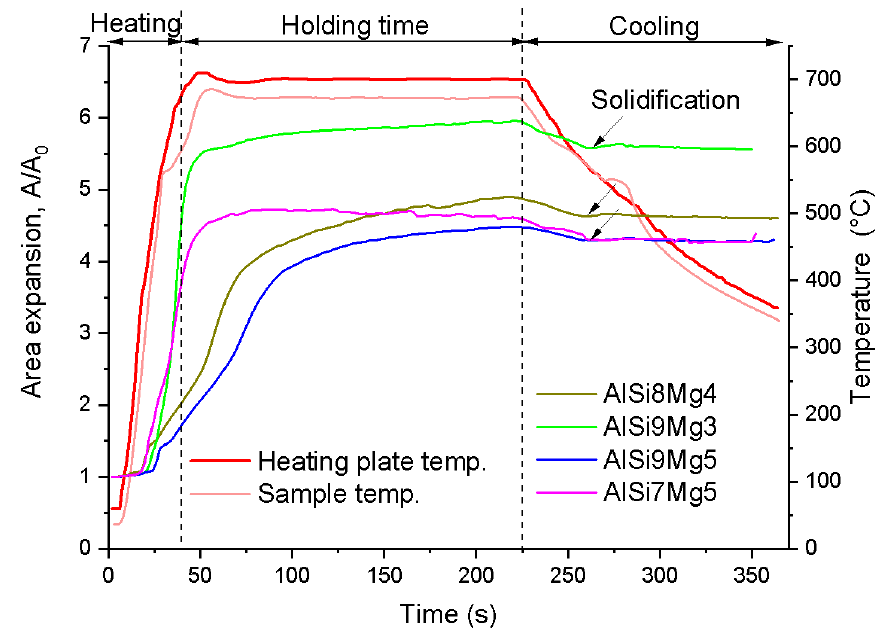
Figure 3. Area expansion curves for selected samples of different alloy composition and the common temperature profiles of the heating plate and the sample. Three experimental stages are indicated, namely, heating, holding for 180 s at 700 °C, heating plate temperature, and natural cooling after switching off the power. Black arrows indicate the solidification point in the expansion curve.